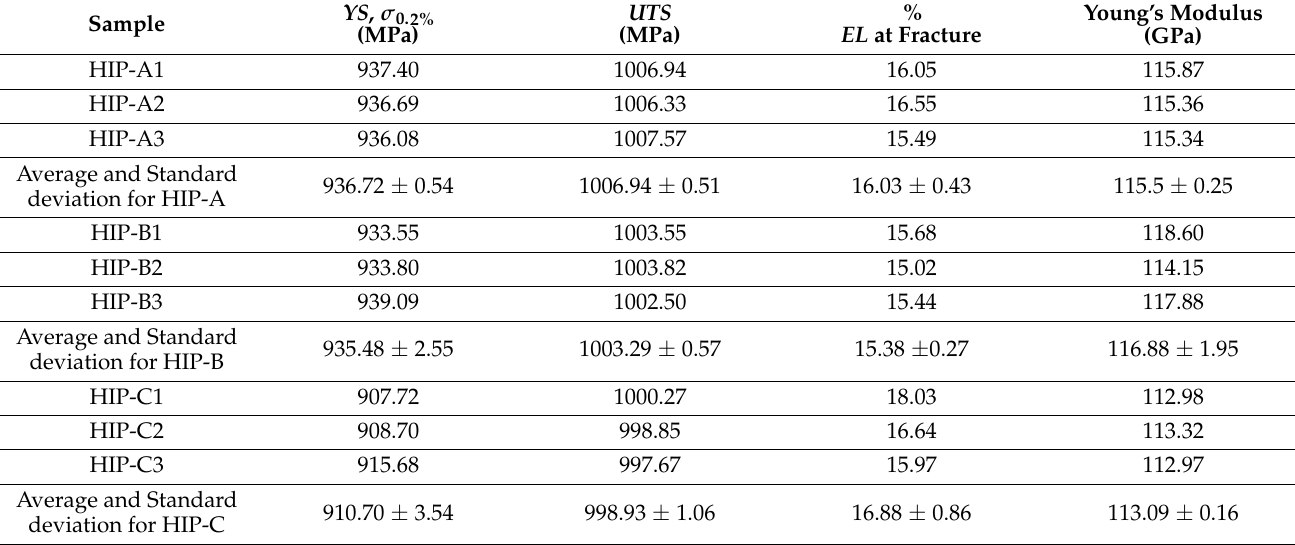
Table 3. Tensile properties determined from the hot isostatically pressed (HIP) Ti-6Al-4V ELI alloy samples.